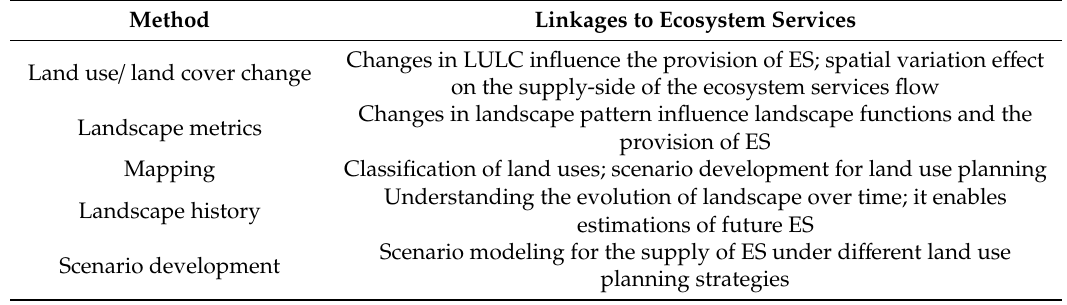
Table 1. Linking land use change in mountain regions with ecosystem services.